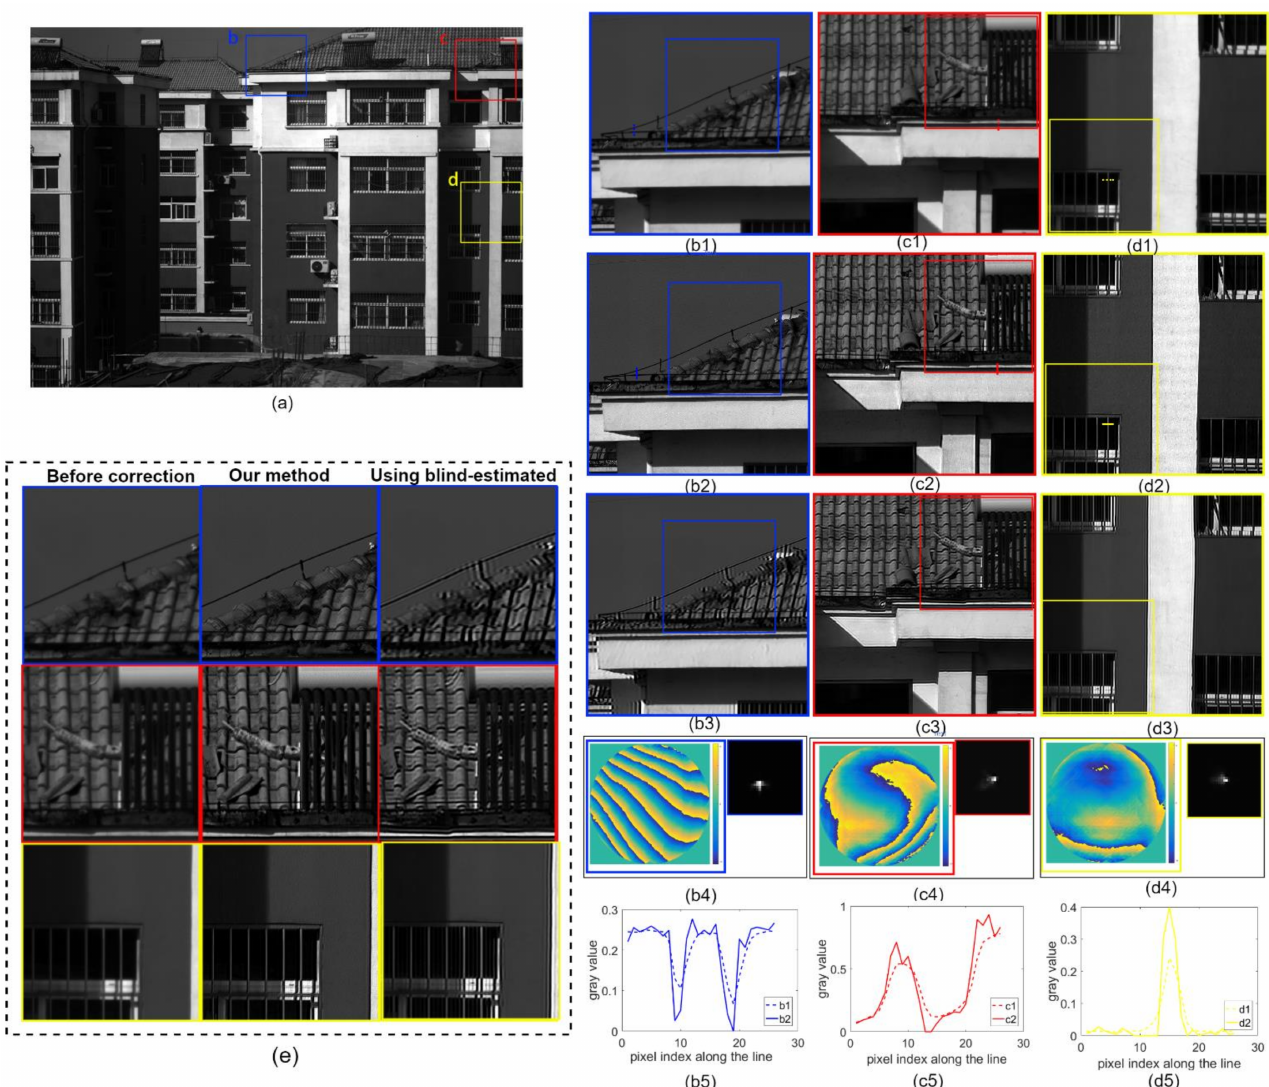
Figure 10. Results for the building image. ( a ) Full FOV image captured by our inexpensive industrial lens. The pupil function and PSF of each small region denoted by ( b1 – d1 ) varied spatially, as shown in ( b4 – d4 ). The deconvolution results ( b2 – d2 ) show that the spatially varying aberrations were adequately corrected after processing. ( b3 – d3 ) The restored results using blind-estimated PSFs. ( b5 – d5 ) Line profiles at the underlined places in ( b1 – d1 ) ( b2 – d2 ) to show the improved image sharpness before and after correction using the proposed method. ( e ) The three images on the left are enlargements of the inset frames in ( b1 – d1 ), which are captured as blurred images in different FOV. The three images in the middle are enlargements of the inset frames in ( b2 – d2 ) and are the restored results corrected using the proposed method. The three images on the right are enlargements of the inset frames in ( b3 – d3 ), the results of the correction using the blind-estimation